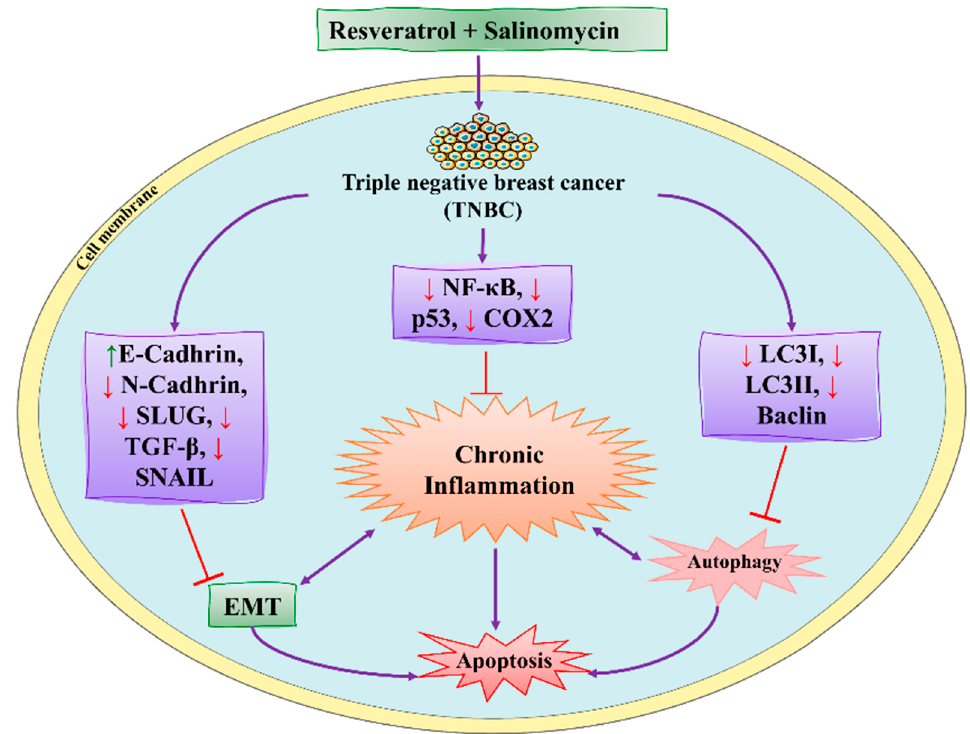
Figure 10. RSVL and SAL synergistic effect against BC cells by inducing apoptosis. NF- κ B: nuclear factor kappa B; p53: inducible gene 3; TGF- β : transforming growth factor-beta; EMT: epithelial to mesenchymal transition; COX2: cyclooxygenase-2. This figure is reproduced from Rai et al. [107]. RSVL and SAL acted synergistically to improve the efficacy of BC therapy.